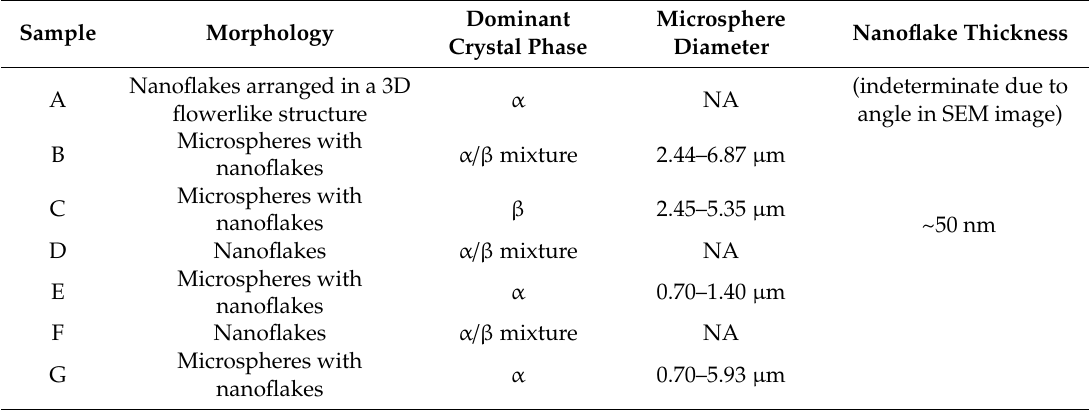
Table 1. Summary of morphologies of fabricated Ni(OH) 2 samples.